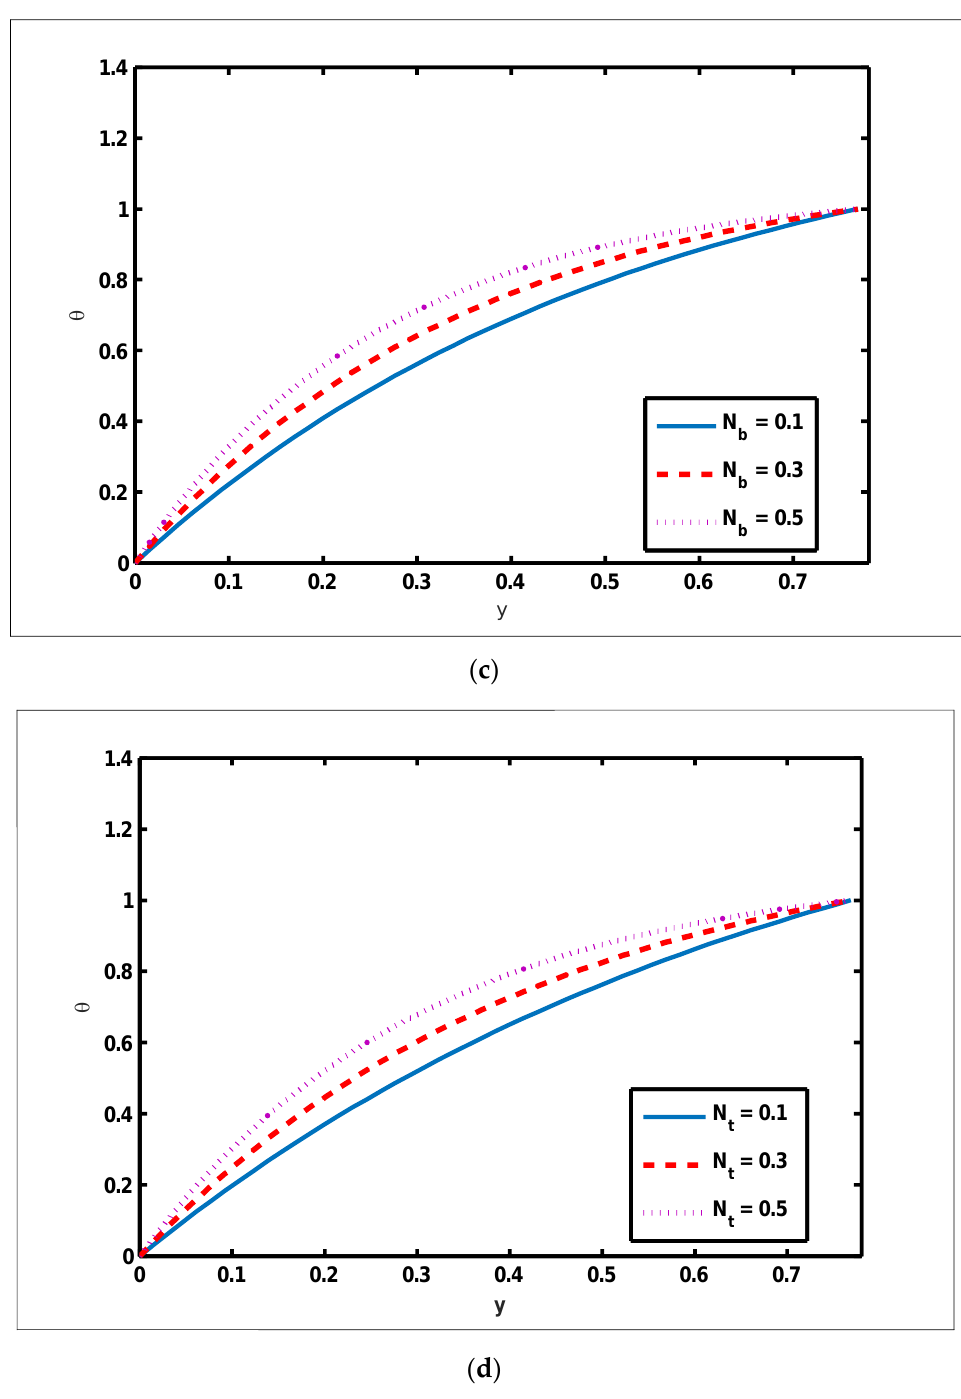
Figure 1. Temperature profile for Soret, Dufour, Brownian motion, and thermophoresis parameters. Values of other physical parameters are ( a ) N t = 0.3, N TC = 1.2, N b = 0.3, b = 0.7, a = 0.3, x = 0.6. ( b ) N b = 0.2, N t = 0.3, N CT = 0.9, b = 0.7, a = 0.3, x = 0.6. ( c ) N t = 0.3, N TC = 1.2, N CT = 0.9, b = 0.7, a = 0.3, x = 0.6. ( d ) N b = 0.2, N TC = 1.2, N CT = 0.9, b = 0.7, a = 0.3, x =